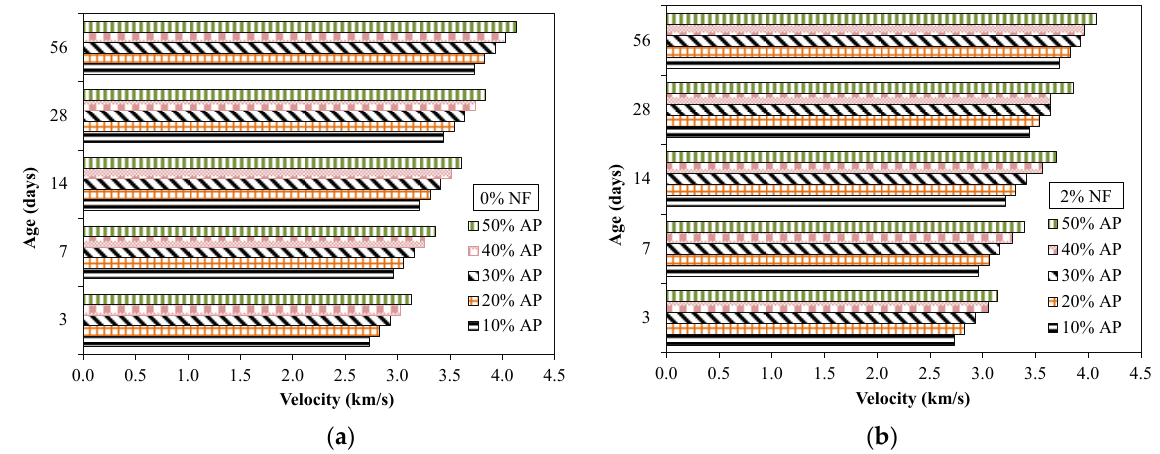
Table 7. Coefficient of variation for ultrasonic pulse velocity results.